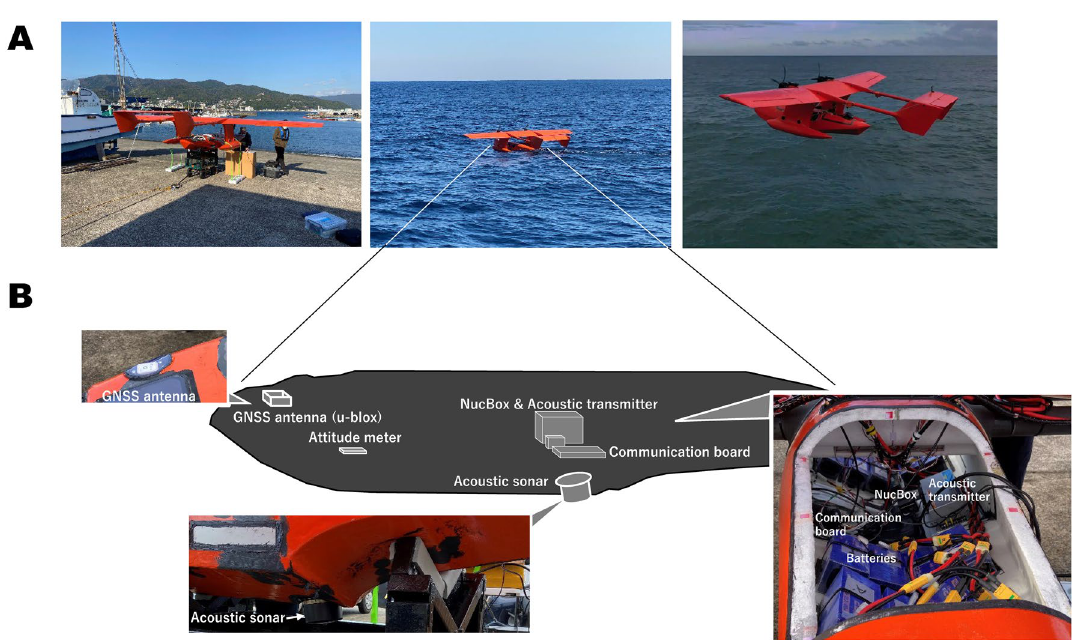
Figure 3. ( A ) Photographs of the UAV HAMADORI6000 prototype model used in this study. From left to right: before departure, during observation, and during flight test. ( B ) Internal configuration with photographs of the GNSS antenna, acoustic sonar, and control Movie S2 shows the movement of the UAV along the survey line during observations. Observations can be stably performed while the acoustic sonar is submerged in seawater. During observations, flight, sea surface navigation, and sound transmission are remotely controlled by a flight controller (Holybro Pixhawk 4). Since this experiment was preliminary, the position of the seafloor was determined with metre-level-precision, which was accomplished using only real-time data from the UAV control system (dual-frequency GNSS was not used).